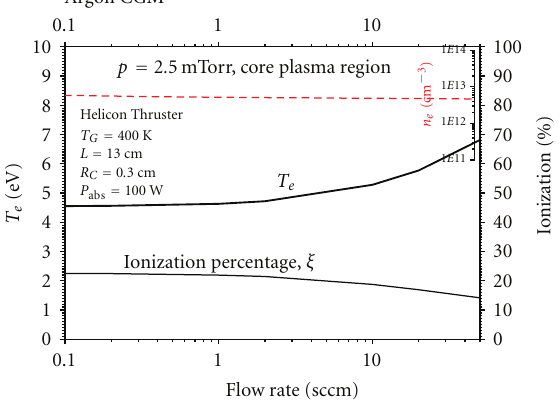
Figure 22: Variation of the electronic temperature and ionization percentage as a function of the flow rate, for a pressure of 2.5